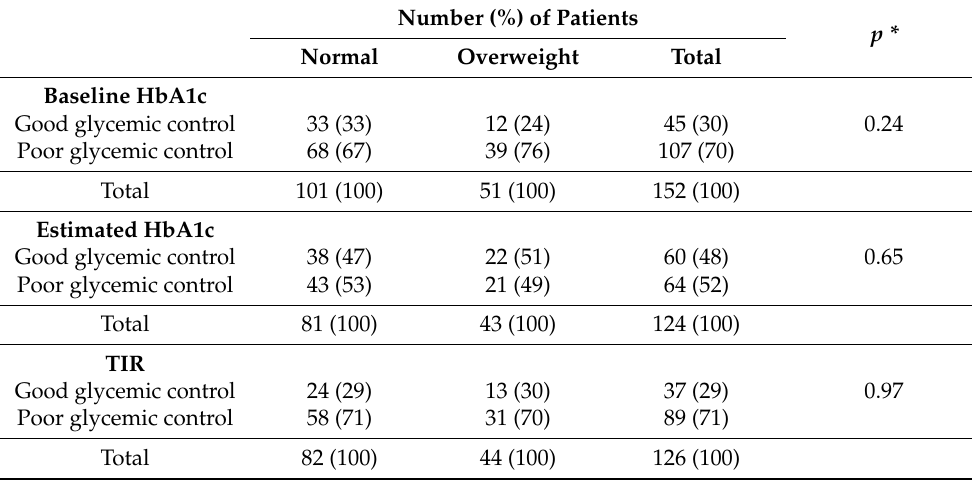
Table 7. Differences in glycemic control according to